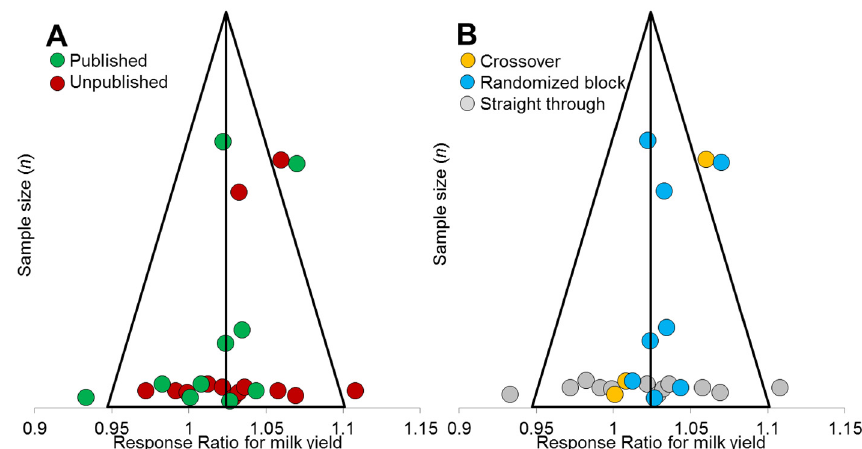
Figure 2. Funnel plot for all studies included in the meta-analysis of milk yield ( n = 23) in order to detect bias between published and unpublished studies ( A ) or between experimental designs ( B ). Triangles represent the median Response Ratio ( R ) and a range equivalent to two standard deviations. If no publication bias is present, the data-points will be organized symmetrically.